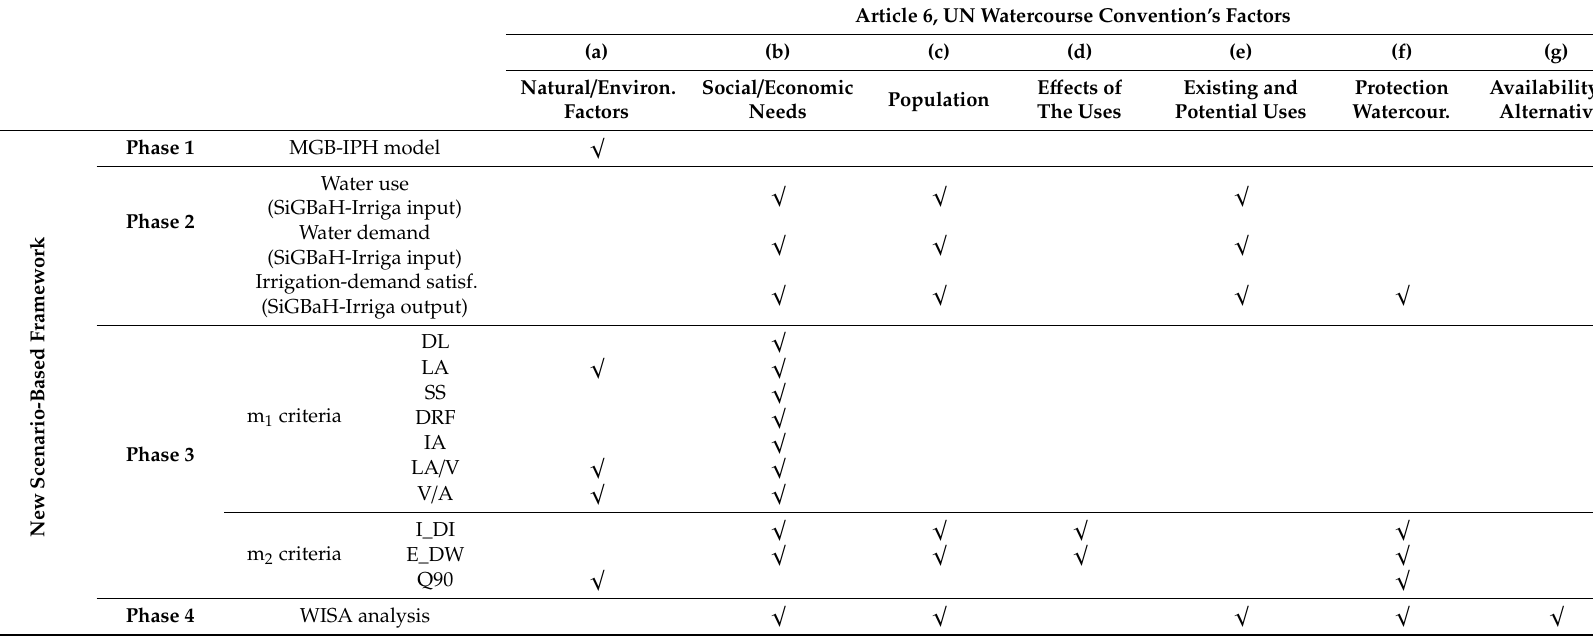
Table 6. United Nations (UN) Watercourses Convention factors [11] taken into account in the new